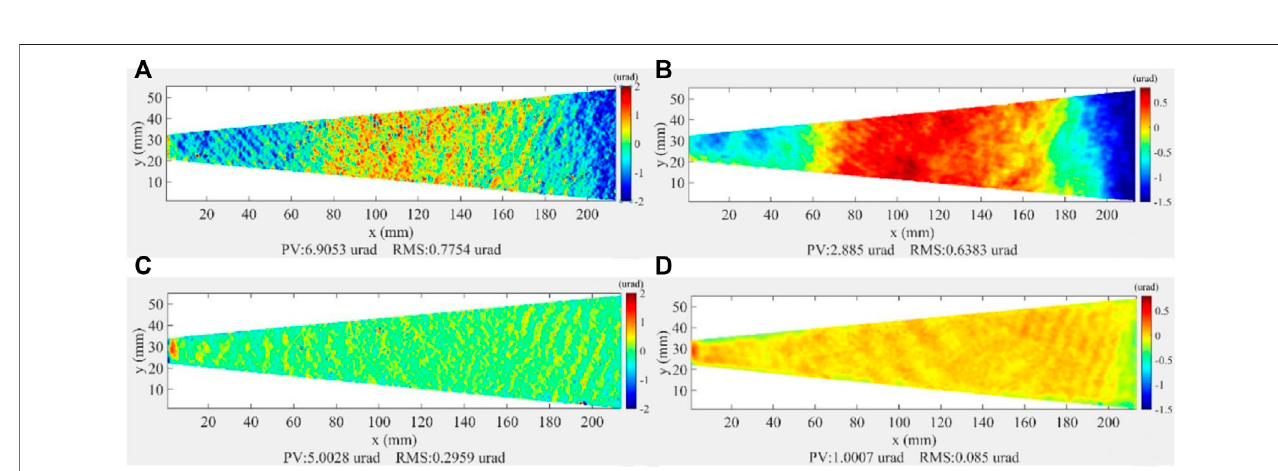
Figure 7 . The height error (including the 2nd order curvature) decreased dramatically from 290.5 to 31.5 nm (PV) and from 74.1 to 8.0 nm (RMS). The height error with subtracting the best- fi t sphere after IBF is further shown in the following diagram of Figure 7 . The residual error is 3.9 nm (PV) and 1.1 nm (RMS) after subtracting the best- fi t sphere, while some small oscillations can still be seen in the height pro fi le. These future work.